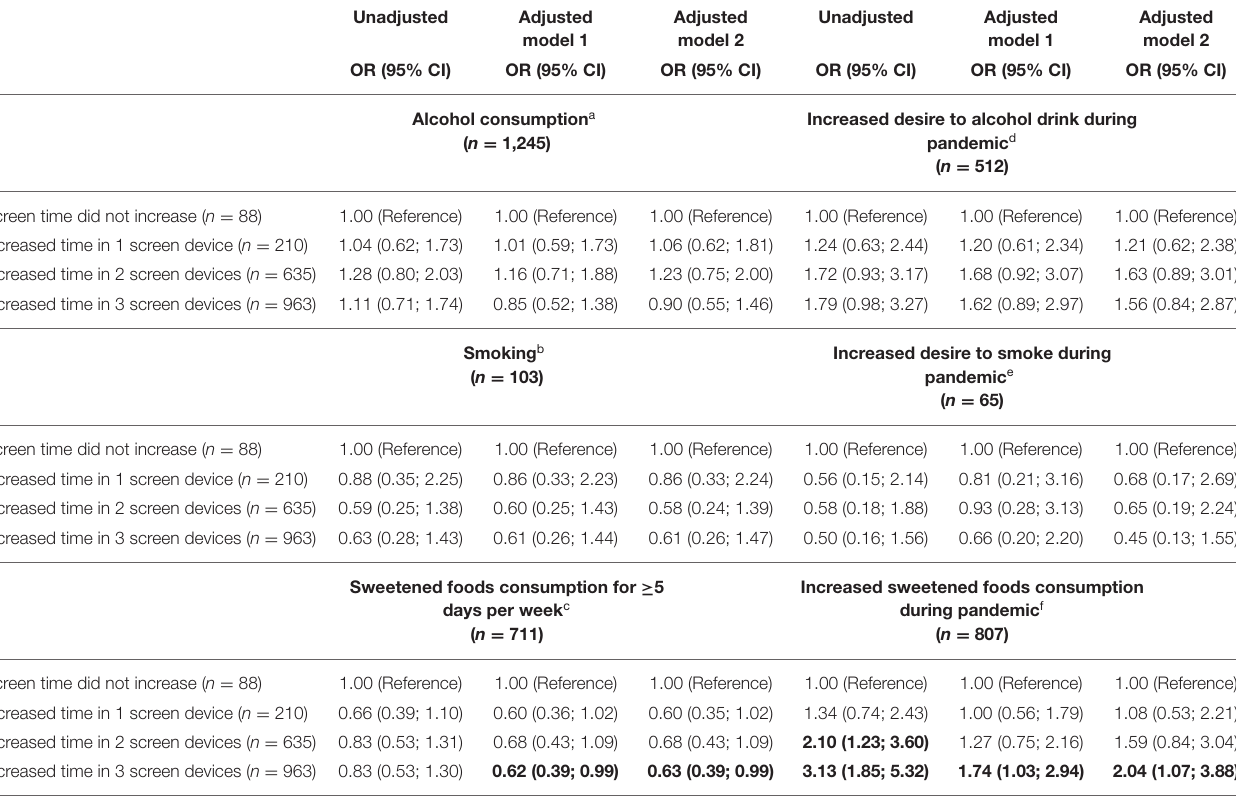
TABLE 3 | Association of the clustering of increased time in different devices with smoking, alcohol, sweetened food consumption, and increased desire during the COVID-19 pandemic in adults ( n =